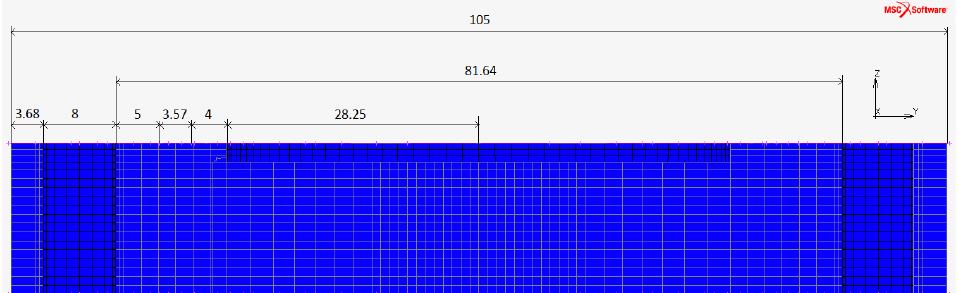
Figure 7. Optimized sizing of the plate: 28.25mm is the active area radius, 4mm is the height of the membrane annulus added to the active area, 3.57mm is the groove width, 5mm were left to give structural strength to the material before the 8mm diameter holes for the bolts, 105mm is the external diameter of the plate.